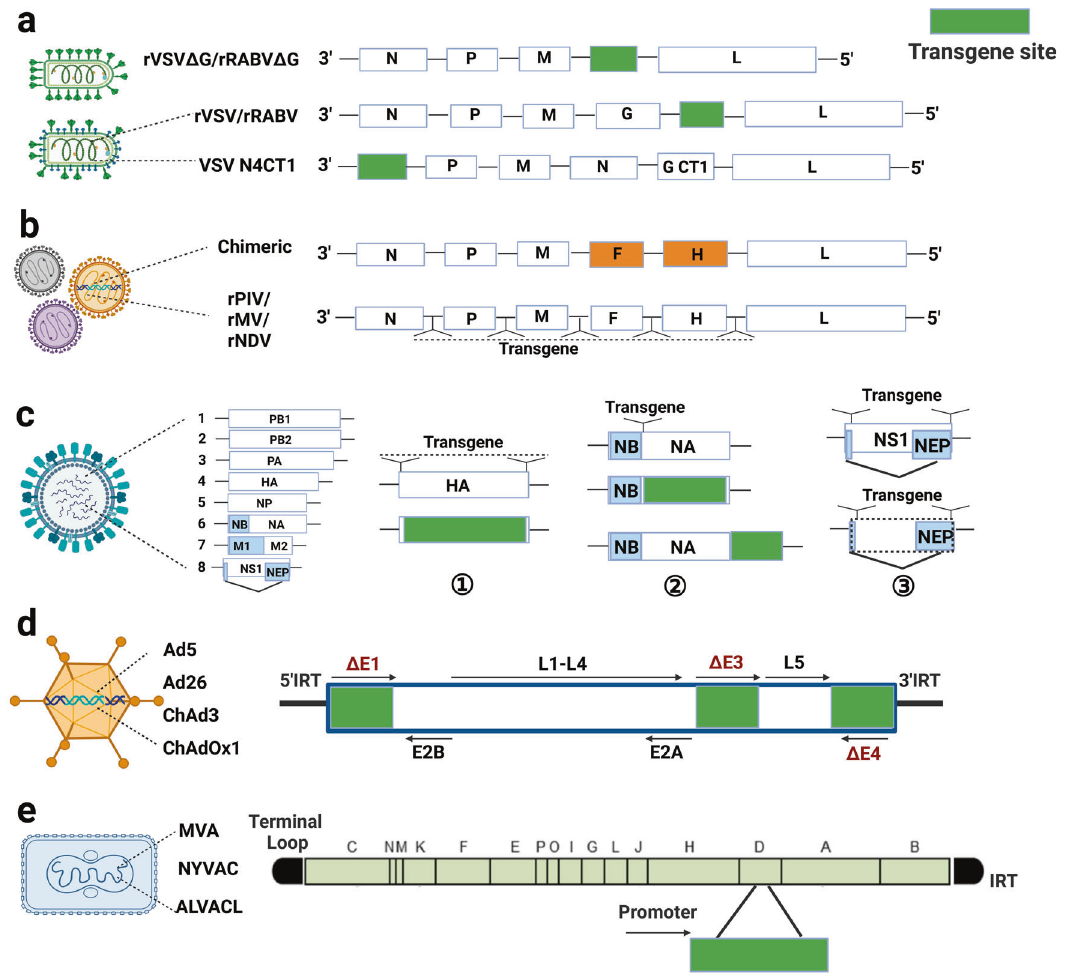
Fig. 1 Design strategies for Vesicular stomatitis virus (VSV), rabies virus (RABV), parain fl uenza virus (PIV), measles virus (MeV), Newcastle disease virus (NDV), in fl uenza virus (IFV), Adenovirus (AdV) and poxvirus for vaccine platforms. a rVSV Δ G/rRABV Δ G, in which the glycoprotein (G) of the vector is replaced by a foreign gene; rVSV/rRABV, an additional transcription unit is involved between G and L of the genome. N4CT1, involves an additional transcriptional unit at the 3 ′ end of the genome, translocation of N gene and truncation of the VSV G cytoplasmic tail. b Chimeric paramyxovirus vector, in which the fusion and hemagglutinin glycoprotein of paramyxovirus is replaced by those of other paramyxoviruses; recombinant paramyxovirus vectors, which involve an additional transcription unit for foreign genes. c Manipulation of the genome of IFV based on HA, NA, and NS. c1. Inserting foreign gene based on HA: the foreign gene is inserted into the receptor binding site of the HA head or the N-terminal of HA; insert the foreign gene in place of HA while retaining packaging sequences. c2. Inserting foreign gene based on NA: the foreign gene is inserted into the stem of NA; preserve the non-coding sequences and adjacent coding regions of NA for transgene in place of NA coding sequence; involves an additional transcription unit at the 5 ′ end of NA. c3. Inserting foreign gene based on NS: insert transgene after the 125th amino acid of NS; retain NS1 and NEP, and introduce 2 A self-cutting site at the end of NS1; insert transgene in place of NS1. d Genome of AdV, E1, E3 and (or) E4 regions are designed for transgene. e Genome of poxvirus, the D transcription units could be replaced by the transgene of choice under the promoter. (Created in